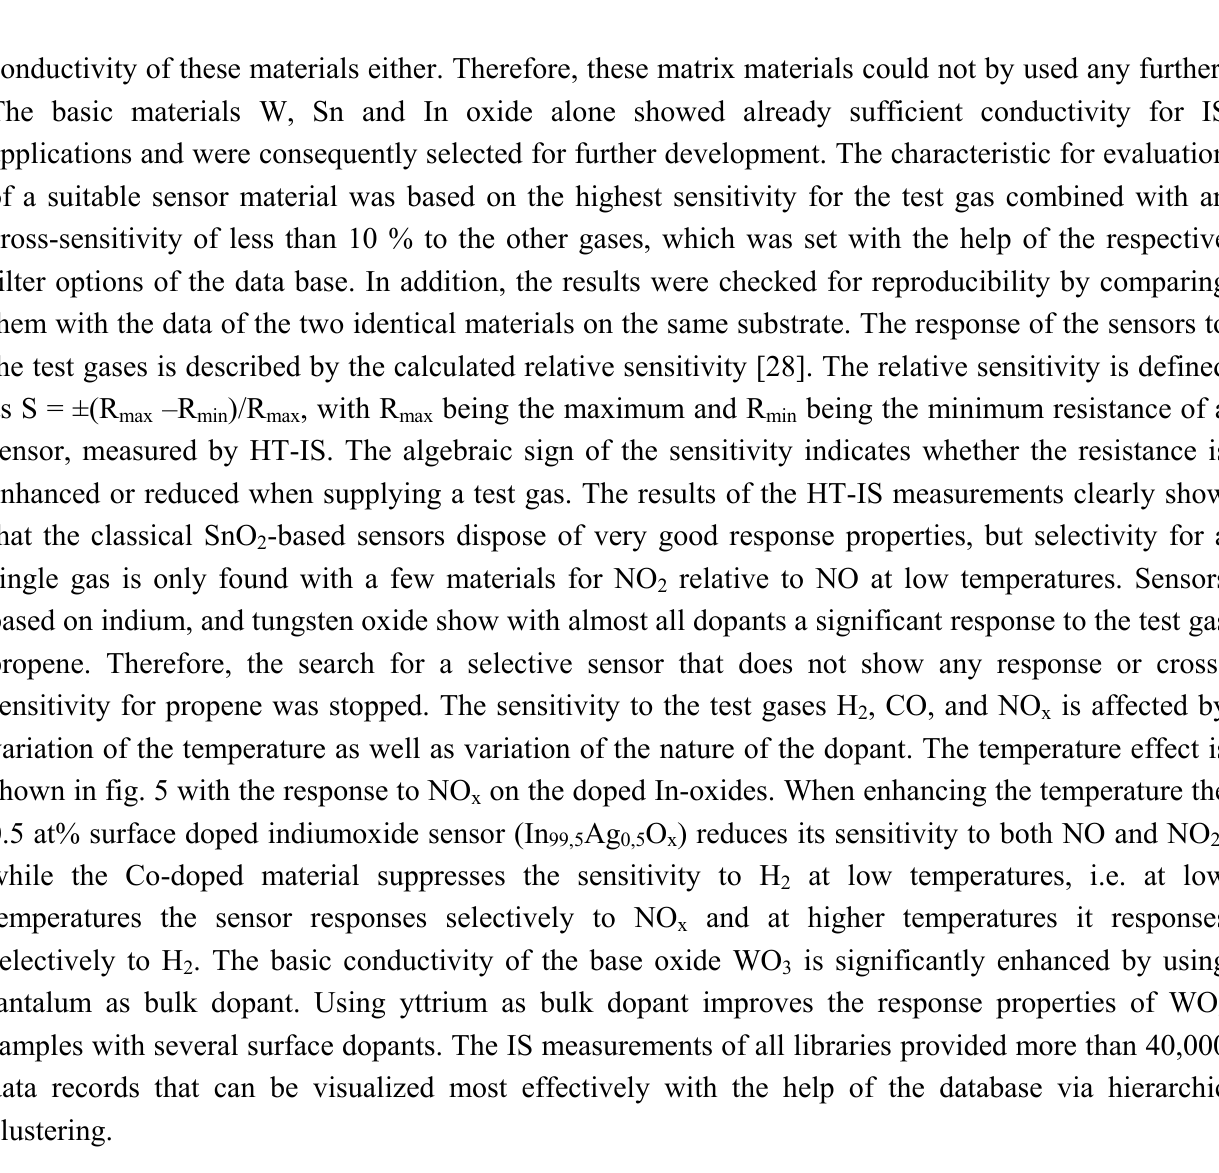
Figure 5. Influence of the temperature to the relative sensitivity S. Sensors: In In Co O (below): X-Axis: chronology of test gas impact: H 99,5 0,5 x propene, synthetic